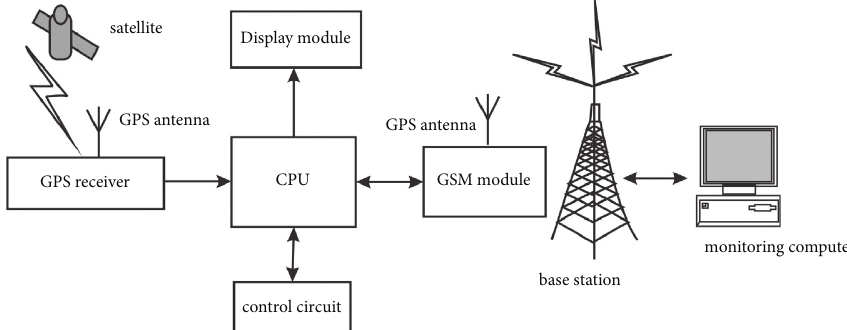
Figure 1: Structure of the logistics tracking system.